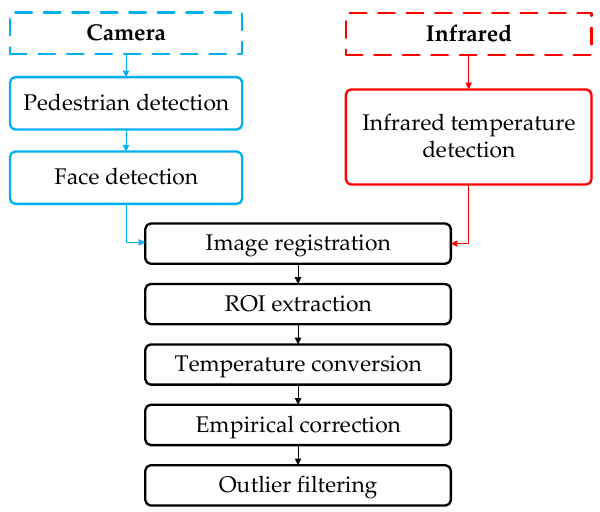
Figure 10. Flow chart of pedestrian body temperature detection.